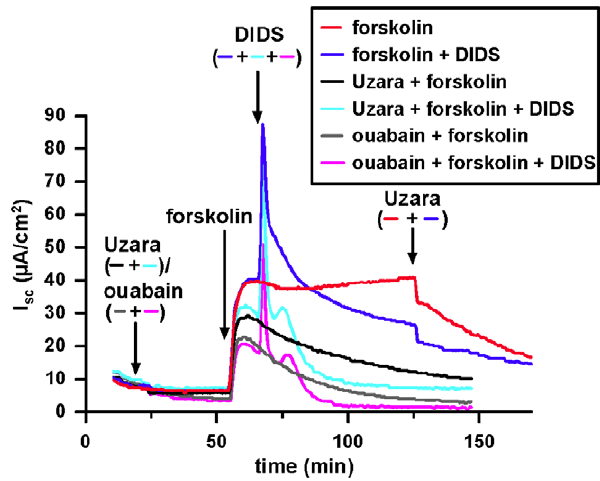
Figure 5. Effects of DIDS on forskolin-induced I SC in the absence and presence of Uzara or ouabain. Experiment in HCO 3 2 free solutions equilibrated with 100% O 2 . Application of 10 m M forskolin induced an I SC that was reduced in the presence of Uzara (50 m g/ml) and ouabain (100 m M). Under all three conditions, application of DIDS (100 m m M) caused a pronounced transient increase in I SC , presumably due to an increase in intracellular Ca 2 + . Similar to the carbachol-induced I SC , the current amplitude was reduced in the presence of Uzara and ouabain. I SC in the presence of DIDS then rapidly decreased, if preparations were pre-incubated with Uzara (light blue) or ouabain (pink). This effect is attributed to additional Na + loading of the cells. Application of DIDS before the addition of Uzara (blue) had no such accelerating